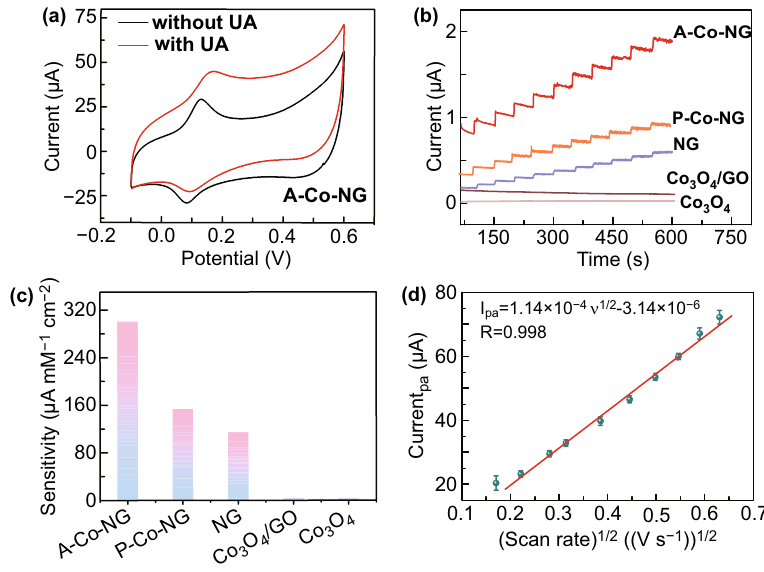
Fig. 3 a CV curves of the A–Co–NG nanozyme recorded in a 0.1 M NaOH (pH = 13) solution without and with 400 µM UA; b Amperometric I - t response of various catalysts upon continuous injection of 5 µM UA at an applied potential of 0.3 V versus SCE in 0.1 M NaOH (pH = 13); c Histogram of sensitivity for UA detection of A–Co–NG, P–Co–NG, NG, Co 3 O 4 /GO, and Co 3 O 4 ; d Anodic peak currents of the cyclic voltam- mograms versus the square roots of a various scan rates from 0.03 to 0.4 V s